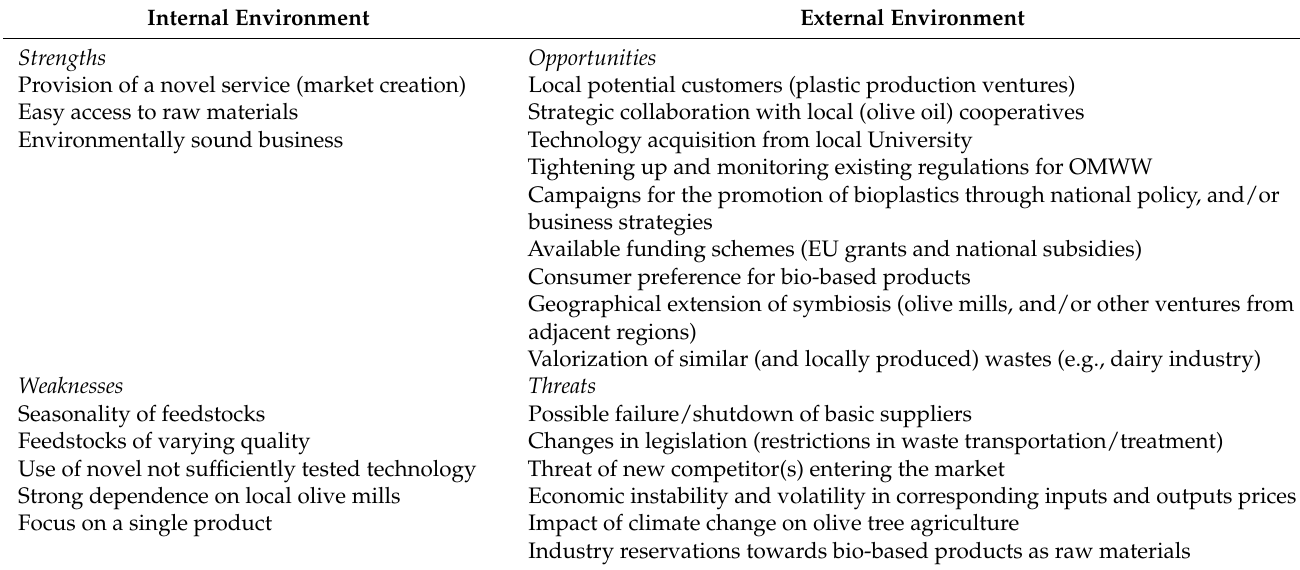
Table 8. The SWOT analysis of the planned